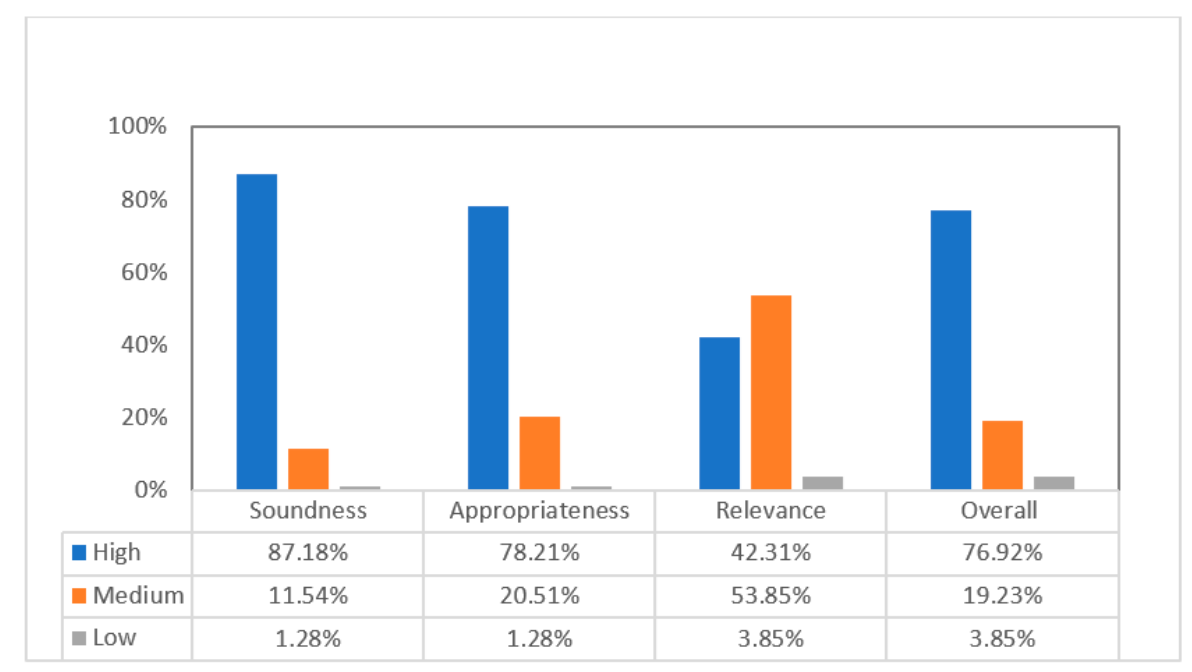
Figure 1. Distribution of the WoE Scores.